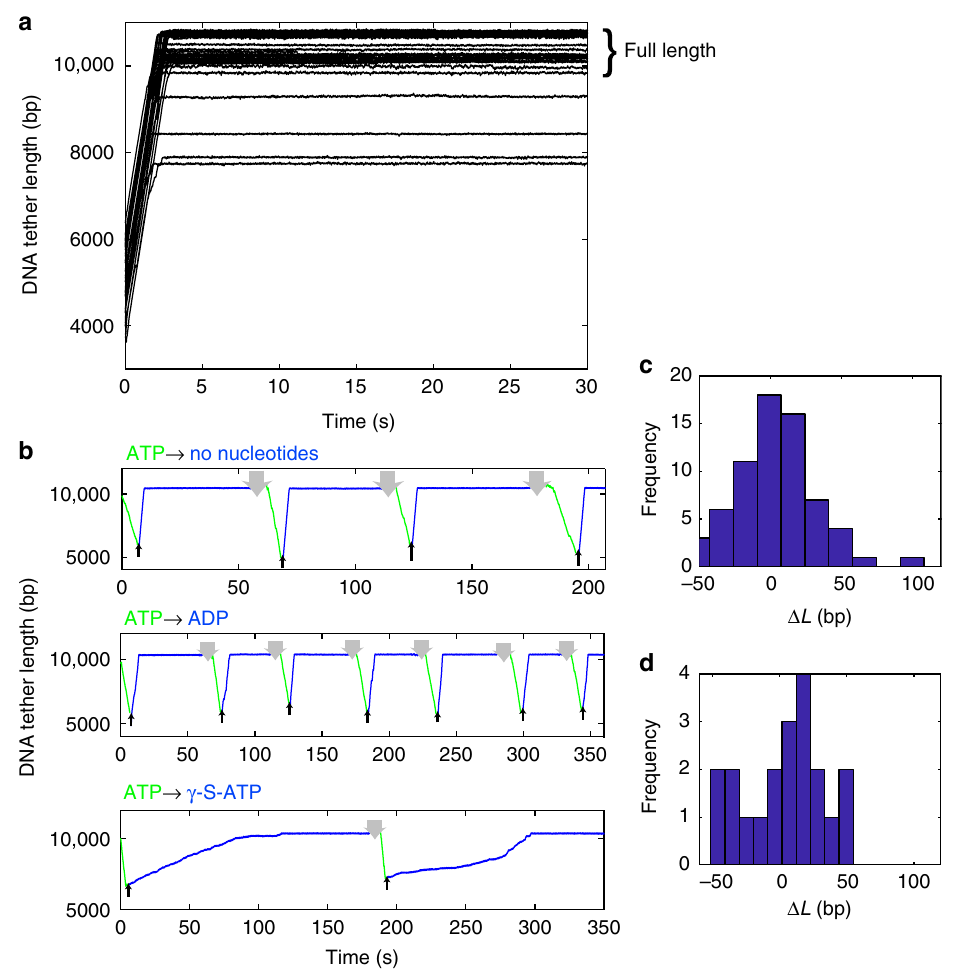
Fig. 5 Arrest of slipping at the end of the DNA template. a Representative examples of measured DNA tether length vs. time with no nucleotides (28 events). The slipping is initially very fast but it suddenly arrests and the fi nal DNA tether lengths are mostly around the full DNA length (~10 kb). b DNA tether length vs. time measurements on single complexes with low (5 pN) applied force where the complex is exposed to ATP, packaging occurs (green lines), and then it is moved out of ATP (blue lines) and into a solution with either no nucleotide, 0.5 mM ADP, or 0.17 mM γ -S-ATP, as indicated in each plot title. When out of ATP rapid slipping occurs, but it arrests at ~10 kbp. After waiting ~60 s to assess the stability of the arrested state the complex is moved back into ATP (green lines) and packaging resumes. The upward arrows indicate times when the complex was moved out of ATP and the downward arrows indicate times when it was moved back into ATP. The process of DNA slipping, arrest, and restarted packaging can be repeated many times. c Histogram of measured DNA length differences Δ L between arrest lengths (plateaus in a ) for each complex. d Histogram of Δ L values measured in control experiments in which arrested complexes were moved in the chamber but did not